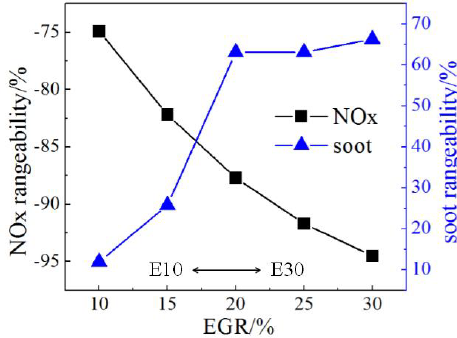
Figure 17. Influence of EGR on emissions at constant excess air